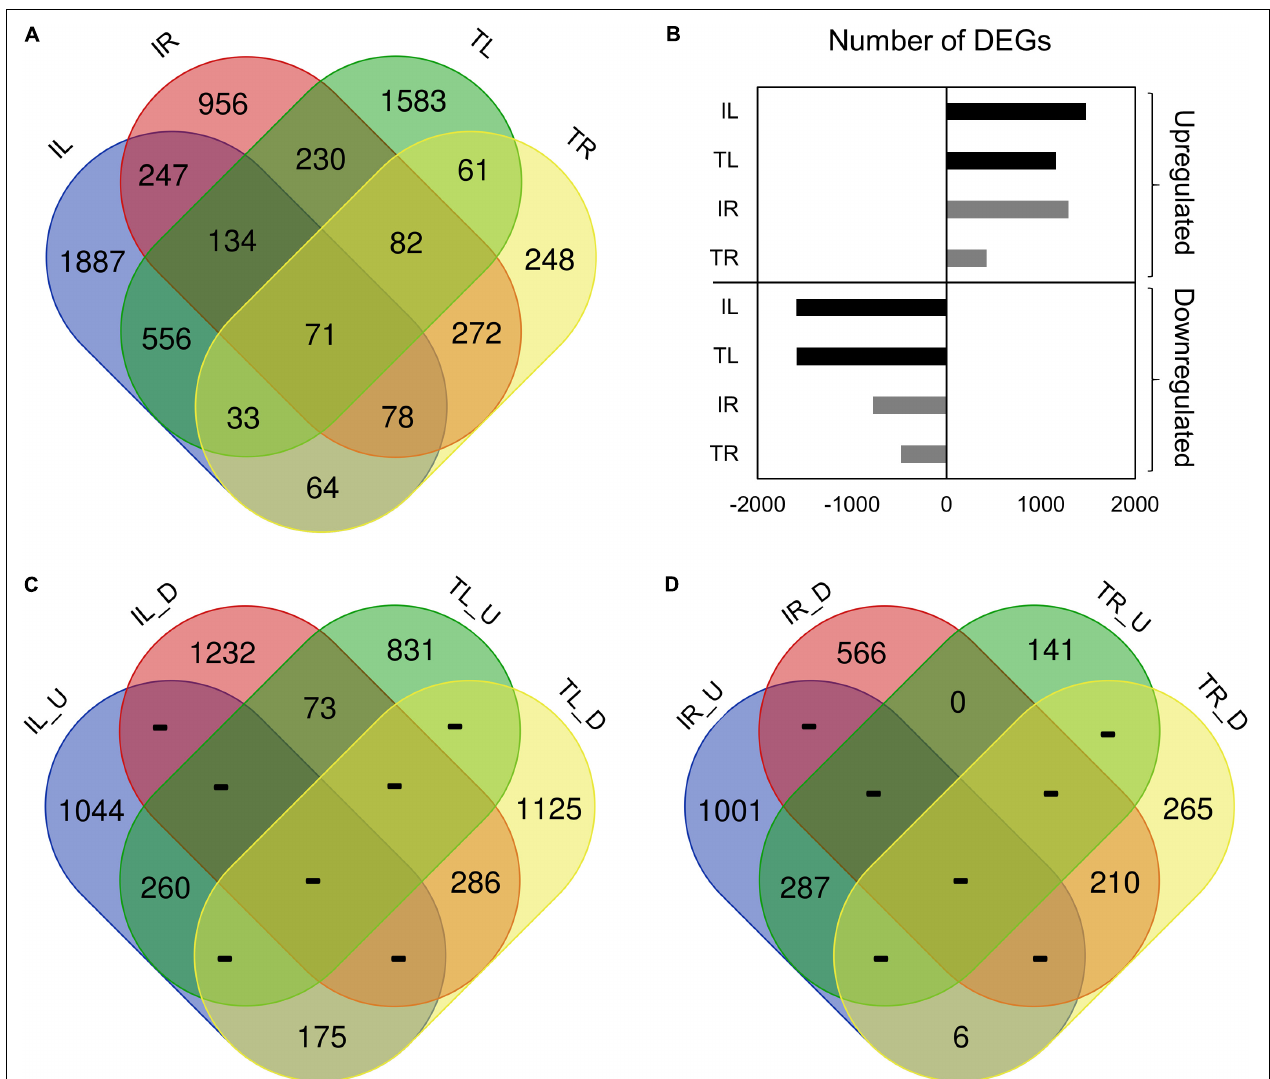
FIGURE 1 | Venn diagram representation of the tissue- and genotype-specific DEGs distribution. IL_U: Ispir Leaf Upregulated; IL_D: Ispir Leaf Downregulated; TL_U: TR43477 Leaf Upregulated; TL_D: TR43477 Leaf Downregulated; IR_U: Ispir Root Upregularted; IR_D: Ispir Root Downregulated; TR_U: TR43477 Root Upregulated; TR_D: TR43477 Root